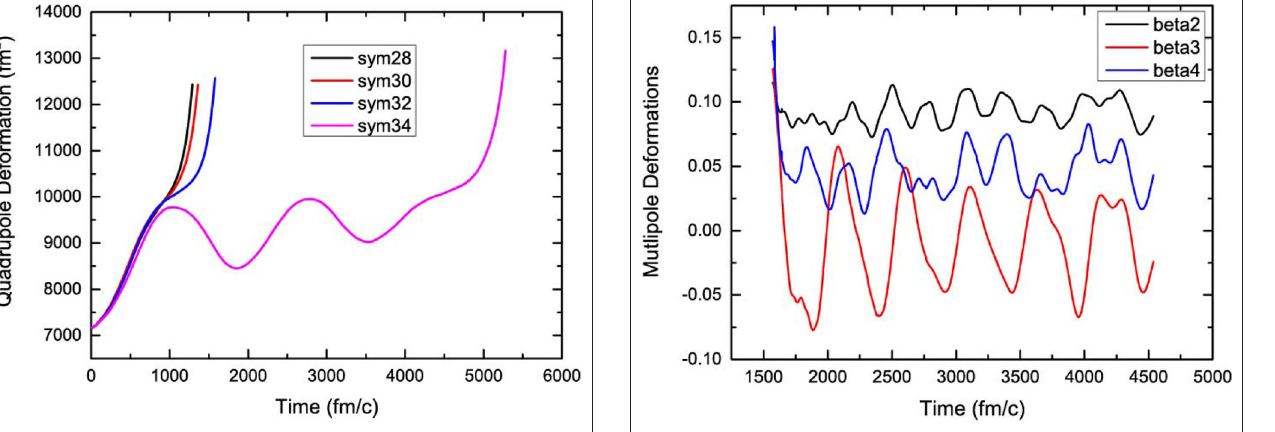
life times of SV-sym28, SV-bas, SV-sym32 are 1260, 1320, 1530